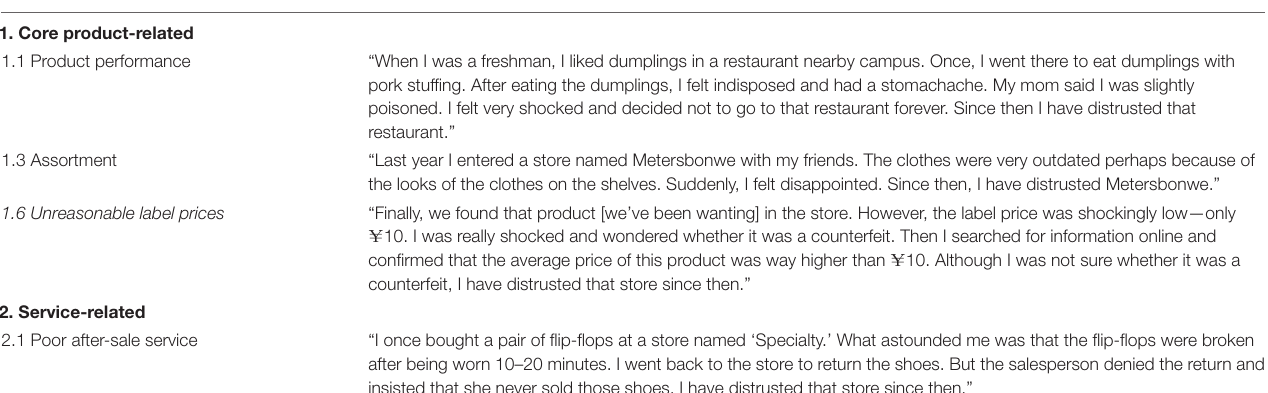
TABLE 3 | Antecedents of distrust and sample incidents. Antecedents Sample